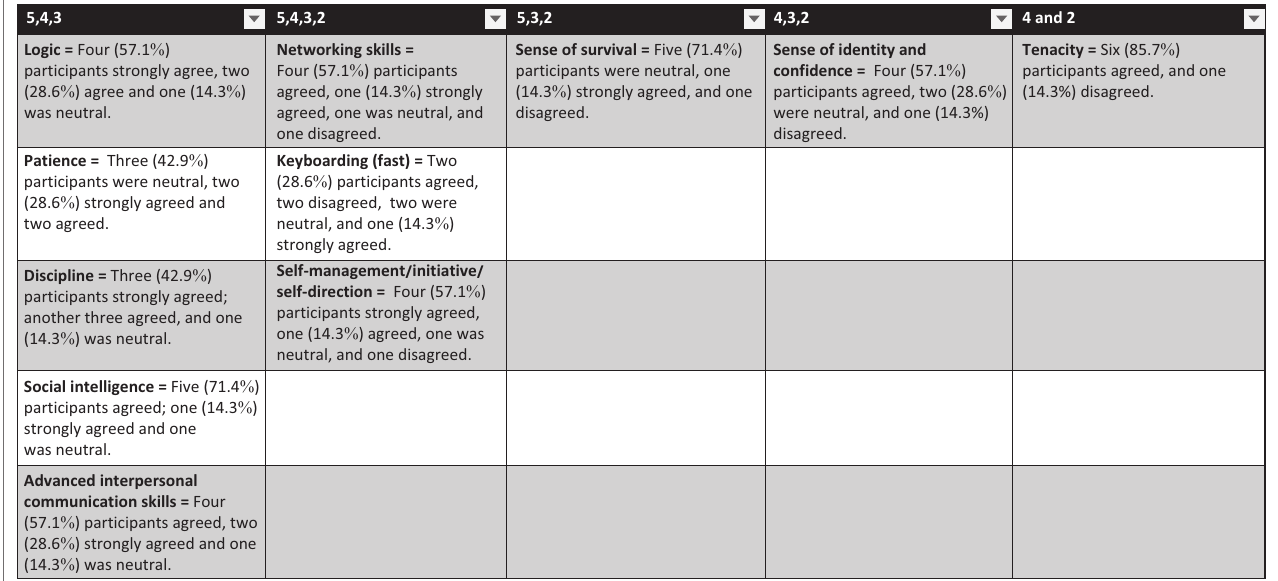
Logic = Four (57.1 % ) participants strongly agree,